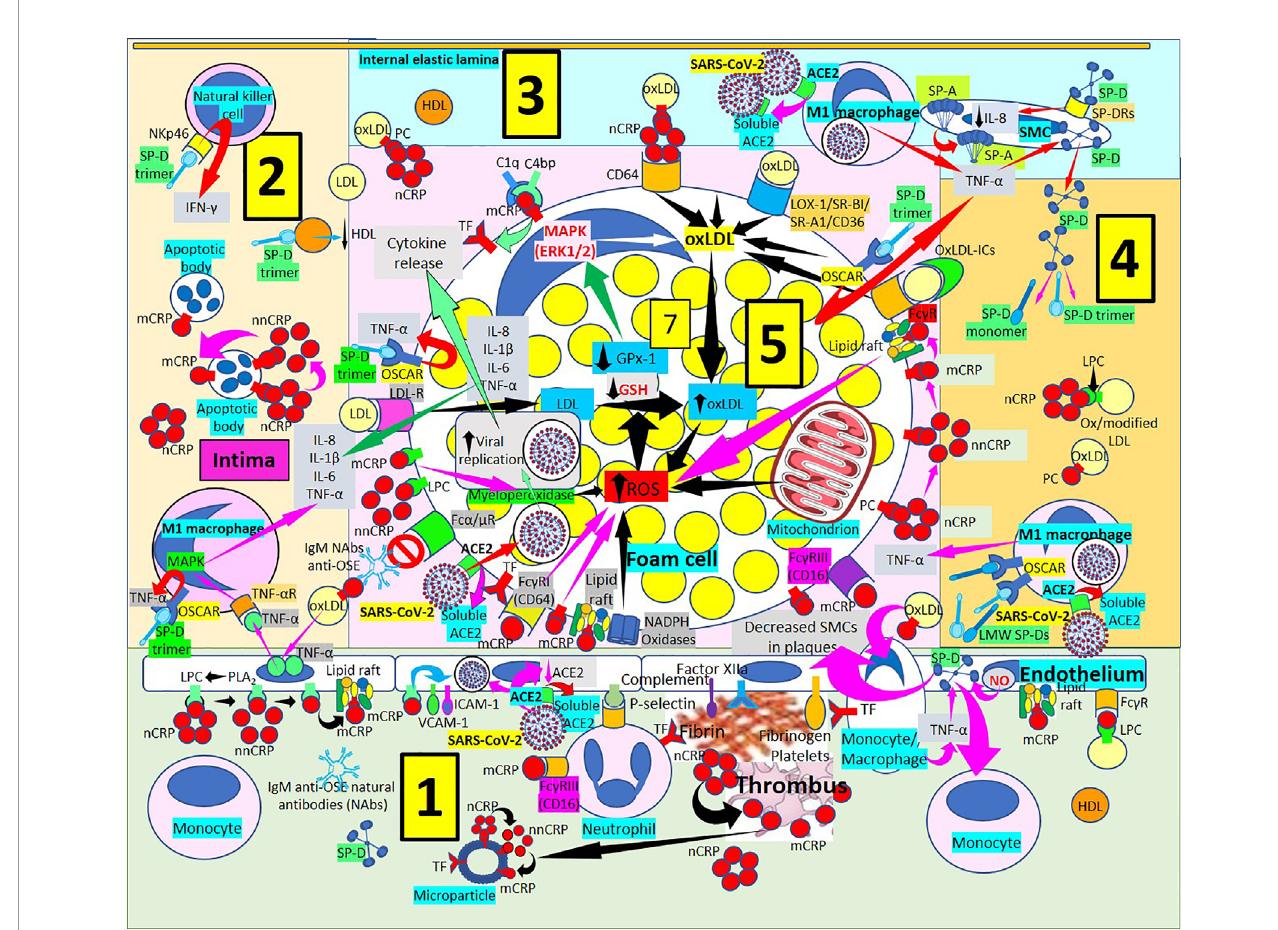
FIGURE 5 | Surfactant proteins in atherogenesis. [1] Monomeric C-reactive protein (mCRP) bound to Fc g receptors (Rs) and lipid rafts is proin fl ammatory and induces endothelial nitric oxide (NO) (right in 1). NO and monocyte/macrophage tumor necrosis factor- a (TNF- a ) increase surfactant protein D (SP-D). SP-D and oxidized LDL (oxLDL) attract monocytes into the intima and SP-D decreases smooth muscle cells (SMCs) in plaques (right in 1). Monocytes/macrophages express tissue factor (TF), and endothelial-bound procoagulants (factor XIIa, fi brinogen) and complement participate in fi brin and thrombus formation further generating mCRP and microparticles (center right in 1). Monomeric CRP via Fc g RIII promotes neutrophil recruitment into the plaques via endothelial P-selectin (center in 1). Circulating native CRP (nCRP) bound to cellular lysophosphatidylcholine (LPC) generated by phospholipase A2 (PLA2) can be dissociated to mCRP with intermediate formation of non-native CRP (nnCRP); mCRP binds lipid rafts and cellular LPC and activate adhesion molecules intercellular adhesion molecule-1 (ICAM-1) and vascular cell adhesion molecule-1 (VCAM-1) (left in 1). Severe acute respiratory syndrome coronavirus-2 (SARS-CoV-2) can invade endothelial cells through angiotensin converting enzyme 2 (ACE2), release soluble ACE2 and reduce endothelial ACE2 (center left in 1). [2] OxLDL-induced endothelial TNF- a release stimulates TNF- a receptor (R)-mediated mitogen-activated protein kinase (MAPK) activation and proin fl ammatory cytokine release. SP-D trimers stimulate osteoclast-associated receptor (OSCAR)-mediated TNF- a release. Dissociation of nCRP to mCRP passing through nnCRP occurs in intimal apoptotic cells. SP-D trimers lower high- density lipoproteins (HDL), and bind NKp46 to activate natural killer (NK) cells releasing interferon- g (IFN- g ). [3] Macrophages invaded by SARS-CoV-2 facilitate soluble ACE2 release that could neutralize more viruses. SP-D trimer OSCAR-mediated TNF- a release from foam cells (center right in 3 and upper right in 5) and macrophages stimulates SP-D synthesis and release from smooth muscle cells (SMCs) allowing further development of trimers and monomers under in fl ammation. SP-A is synthesized in SMCs and SP-D bound to SP-DRs lower IL-8 (right in 3). [4] Low molecular weight (LMW) SP-Ds (trimers, monomers) bind OSCAR in macrophages and release more TNF- a enhancing in fl ammation. [5] OxLDL uptake, increased ROS production and reduced antioxidant activity (glutathione peroxidase, GPx-1; glutathione, GSH) enhance foam cell formation (center in 5). SARS-CoV-2 can invade macrophages/foam cells through ACE2 and release soluble ACE2 (lower left in 5). Monomeric CRP through Fc g Rs and bound to phosphorylcholine (PC) and lipid rafts associated with nicotinamide adenine dinucleotide phosphate (NADPH) oxidases can increase reactive oxygen species (ROS) and TF (lower left and center lower left in 5). OxLDL bound to IgM natural antibodies (NAbs) can block Fc a / m -mediated oxLDL uptake. CRP (most probably mCRP and/or nnCRP) can activate myeloperoxidase and generate ROS (lower left in 5). LDL is taken by LDL-Rs into the cell (center left in 5). LMW SP-Ds (trimers and/or monomers) bound to OSCAR can enhance TNF- a release, and foam cells also release further TNF- a , interleukin (IL)-8, IL-1ß and IL-6 contributing to in fl ammation (center left in 5). Complement component 1q (C1q) and C4b-binding protein (C4bp) compete for mCRP to adjust local complement activation/inhibition balance; mCRP enhances TF expression (upper left in 5). OxLDL is transported into foam cells through CD64 (bound to CRP); scavenger receptors lectin-like oxidized low-density lipoprotein (LDL) receptor-1 (LOX-1), scavenger receptor class B type 1 (SR-BI), scavenger receptor A1 (SR-A1) and CD36; and Fc g Rs (oxLDL immune complexes, oxLDL-ICs) (upper left, center and right in 5). Native CRP generates mCRP in foam cell membranes and lipid raft-bound mCRP enhances ROS (center right in